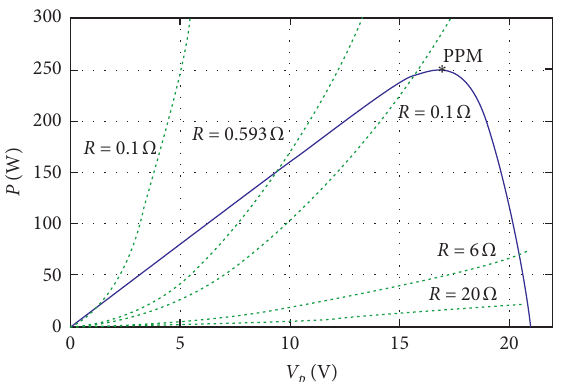
Figure 1: Evolution of the operating point with a direct link between the source and the